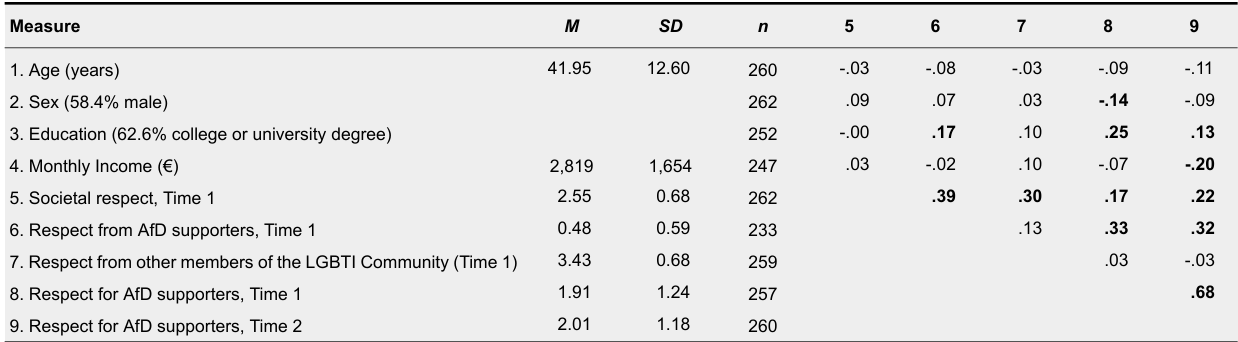
Means, Standard Deviations, and Intercorrelations for Members of the German LGBTI Community – (Study 2)